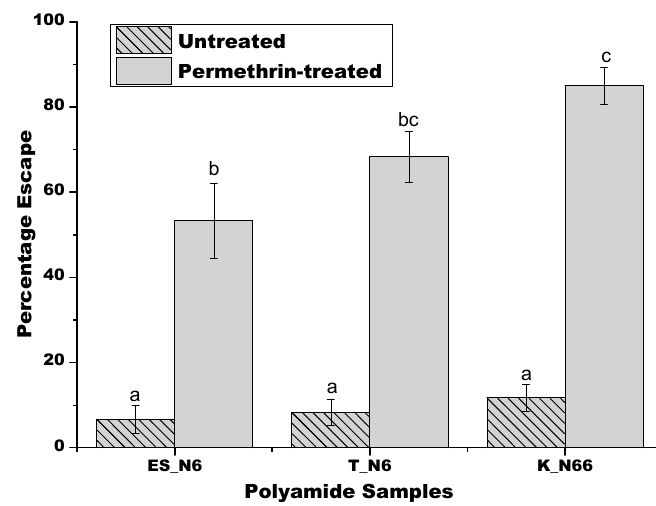
Figure 10. Contact irritancy of various untreated and permethrin-treated fabrics against adult female Aedes aegypti after a five-minute exposure interval. The differences in efficacy are described by the letters above, with each bar highlighting statistically significant comparisons (one-way ANOVA with a post-hoc Bonferroni t-test).